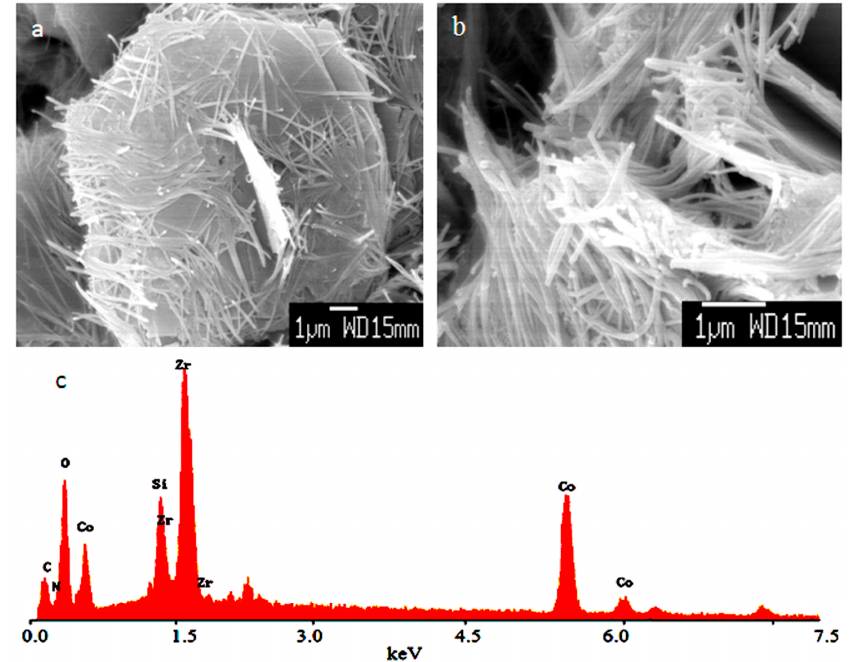
Figure 2. Co–Si LDHs after zirconium inclusion: ( a ) SEM image, ( b ) SEM image after magnification, ( c ) energy-dispersive X-ray spectrometer (EDX).